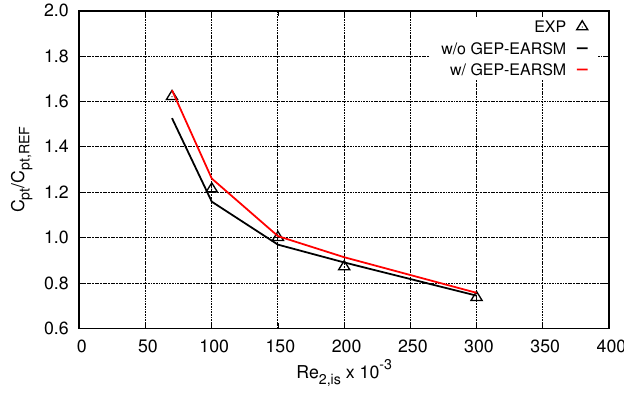
Figure 9. Cascade lapse rate (midspan losses, x / C x , ms = 1.46 ).